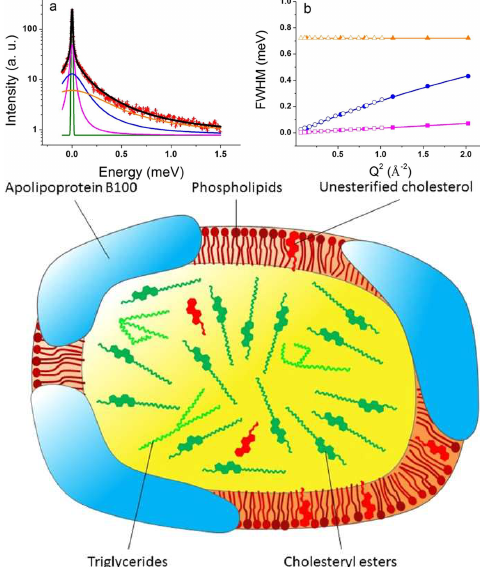
Fig. 17 . QENS data at Q = 1.0 Å -1 with fits (top left) and the associated signal broadening (top right) from lipoprotein particles (bottom) measured at 310 K and 20 bar (reprinted with permission from [106]). The FWHM values of the three Lorentzian distributions as a function of Q-squared as presented in the top right panel were obtained at IN5, ILL (smaller Q-range, open symbols) and IN6, ILL (filled symbols) and fitted using a translational diffusion model (magenta points), a jump-diffusion model (blue points), and a rotational diffusive model (orange points).